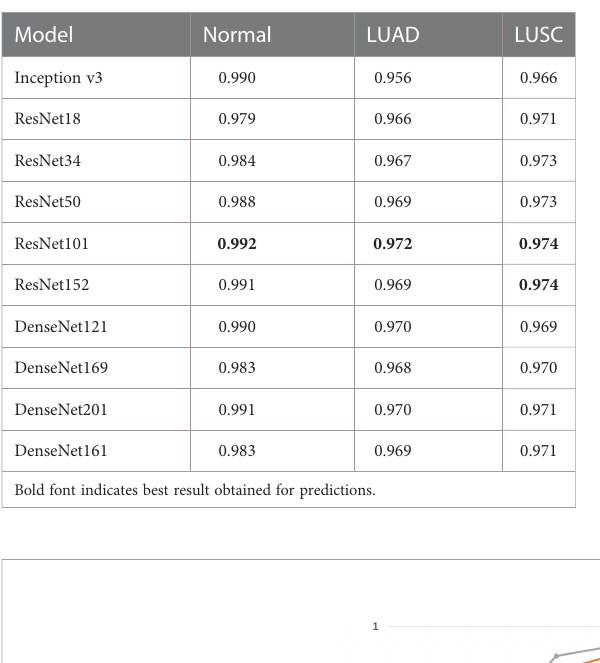
TABLE 3 Area Under the Curve (AUC) achieved by different models (%).